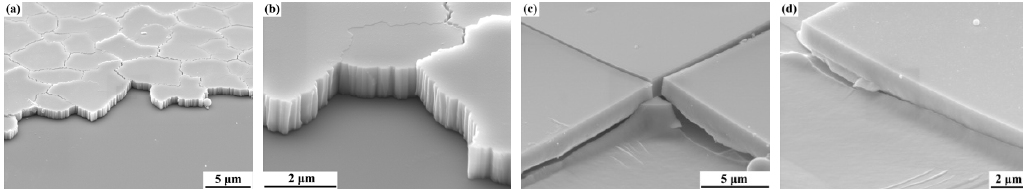
Fig. B Fracture surface morphology of polycrystalline and single-crystal 7YSZ splats on (a, b) Al 2 O 3 and (c, d) 18YSZ substrates, respectively. Zigzag crack path and columnar grains with sharp corners were clearly observed in polycrystalline 7YSZ splats (a, b), while the cross sections of single-crystal 7YSZ splats were quite